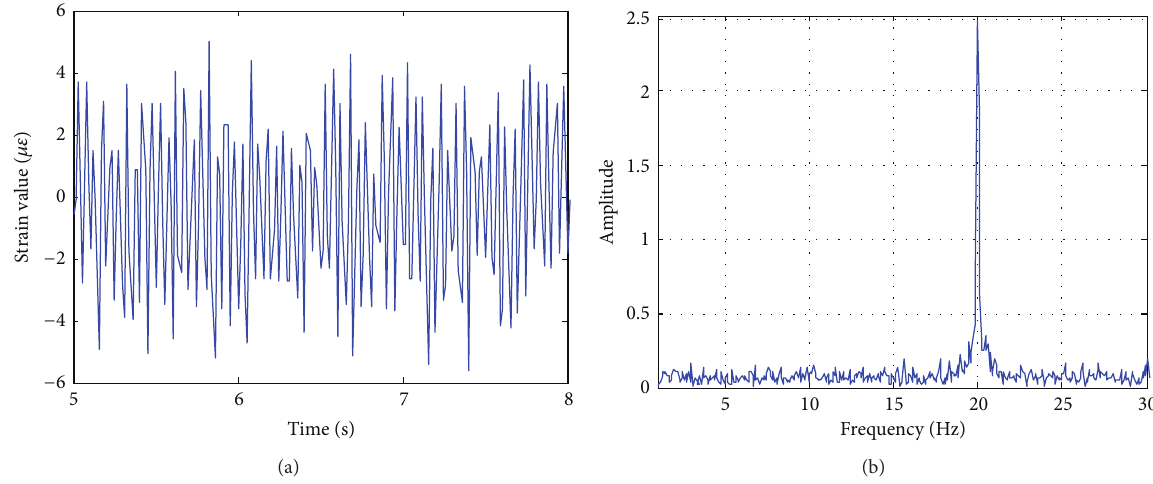
Figure 13: 20 Hz input wave: (a) strain signal and (b) frequency spectrum of the signal.